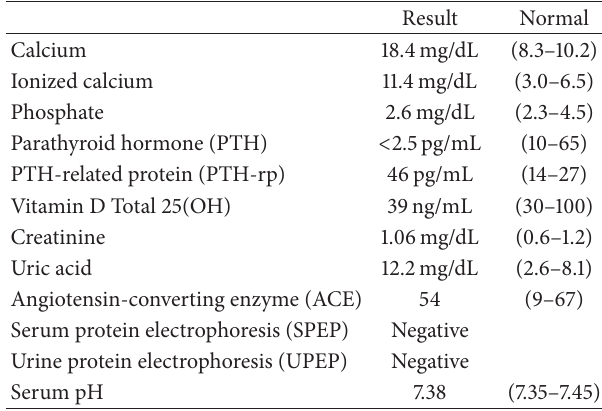
Table 1: Pertinent laboratory